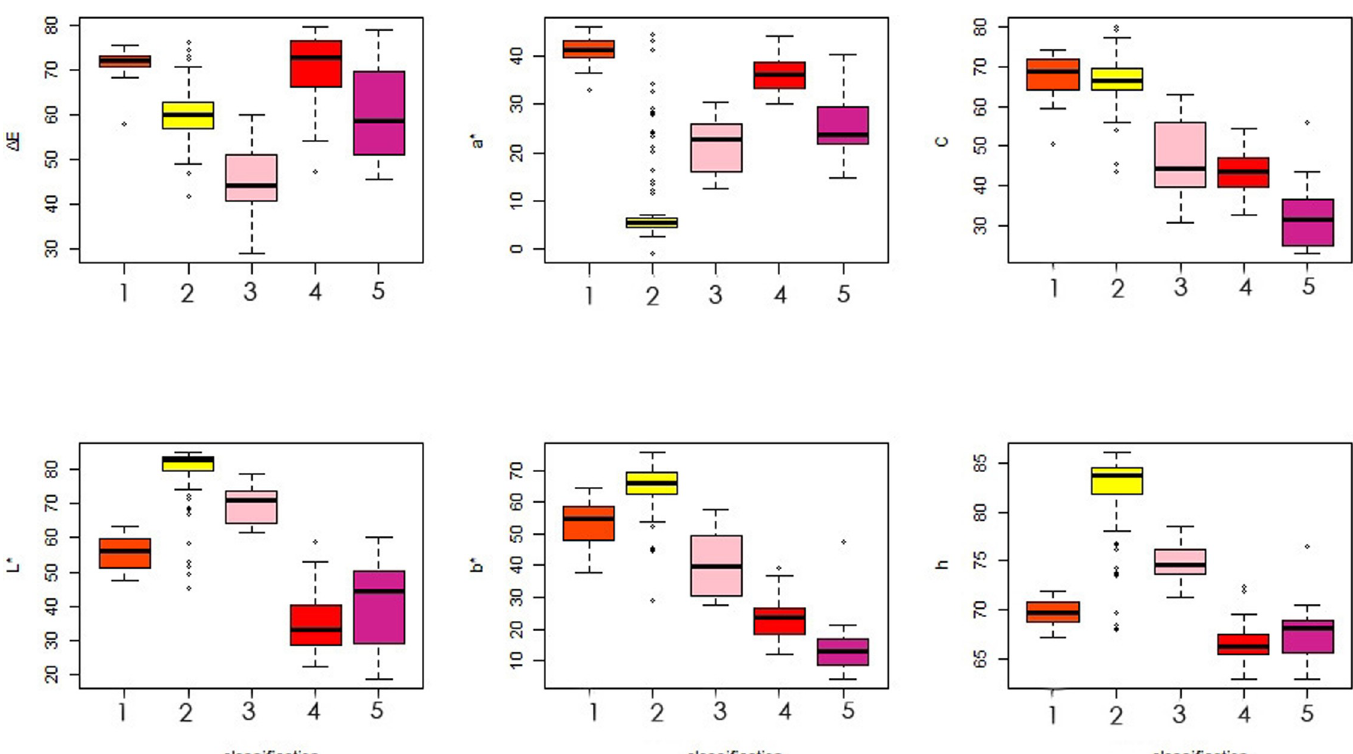
Fig 4. The box plot based on the limb of petal color phenotype for Hemerocallis according to CIELab data. 1: Orange group; 2: Yellow group; 3: Pink group; 4: Red group; 5: Purple group.